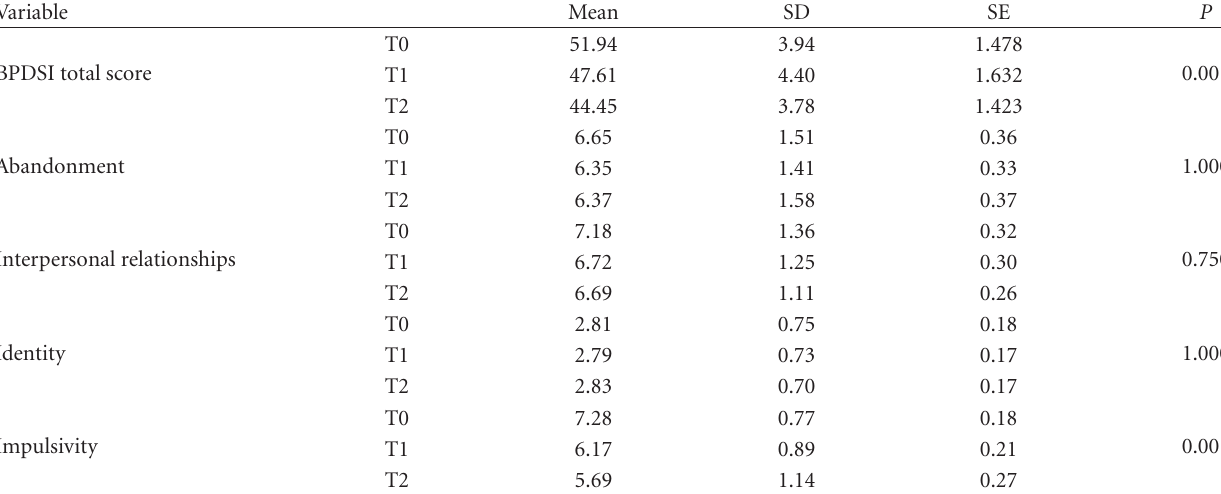
Table 2: Results of analysis of variance (ANOVA) for repeated measures with Bonferroni correction for multiple comparisons, performed with BPDSI total score and items “abandonment”, “interpersonal relationship”, “identity”, and “impulsivity”. Variable Mean SD